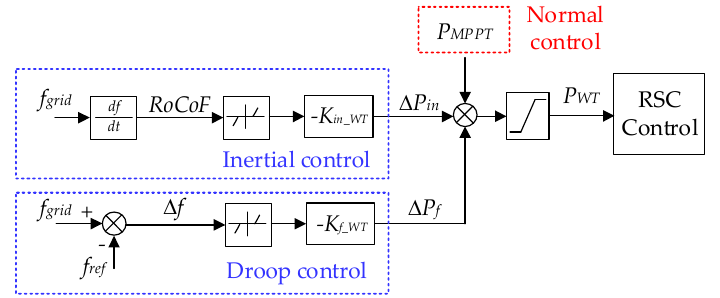
Figure 3. Frequency droop and inertia control for DFIG.